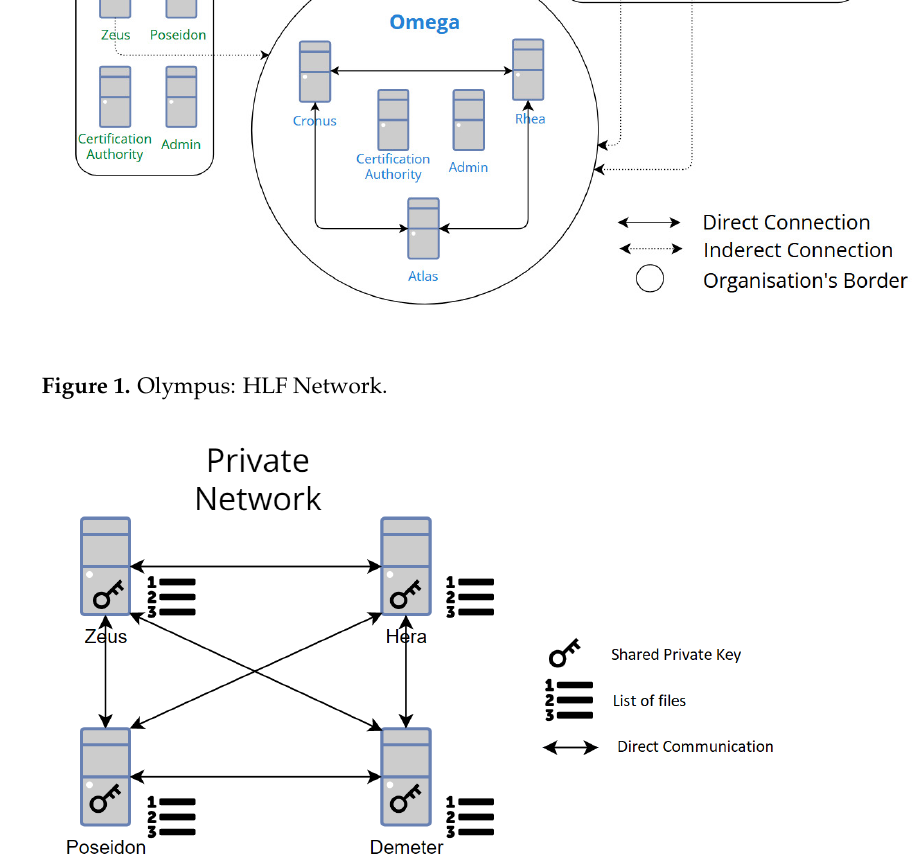
Figure 2. Olympus: IPFS